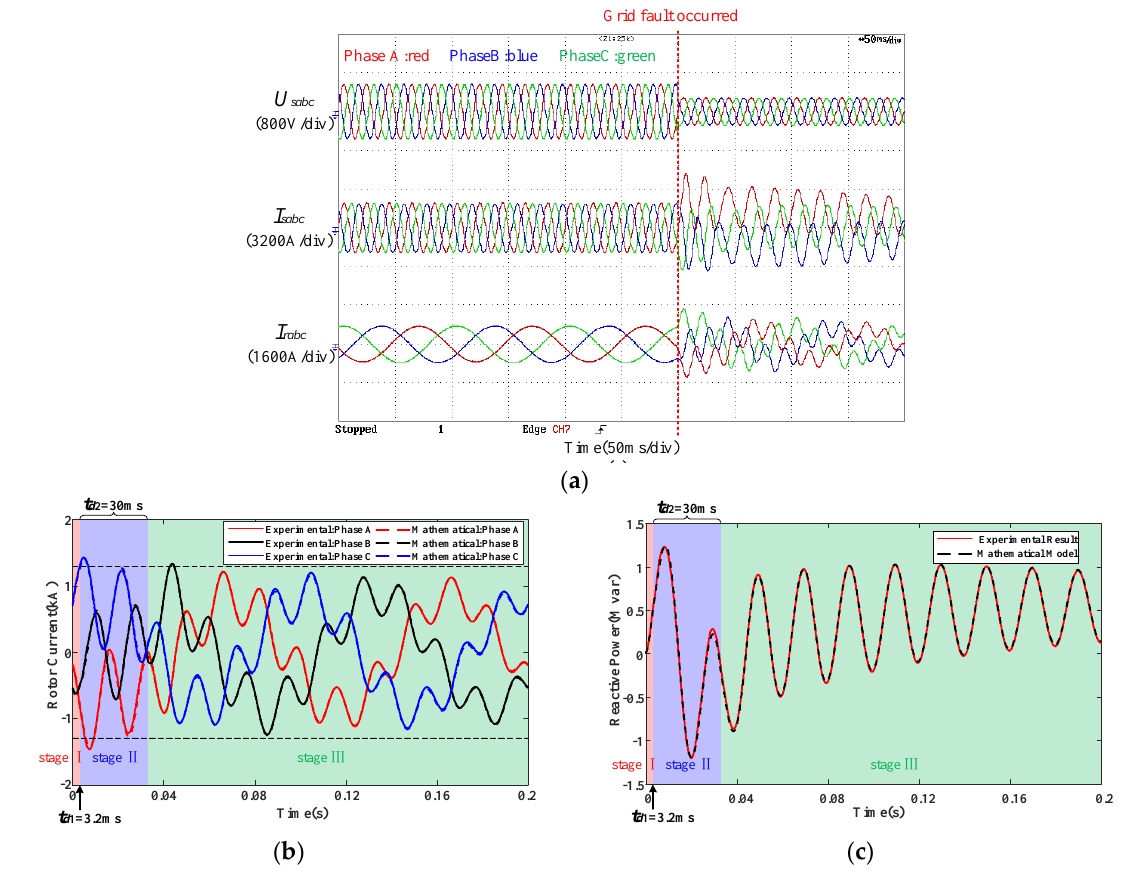
Figure 7. Grid voltage steps down to 0.5 pu. ( a ) Experimental results; ( b ) comparison of rotor current; ( c ) comparison of reactive power.